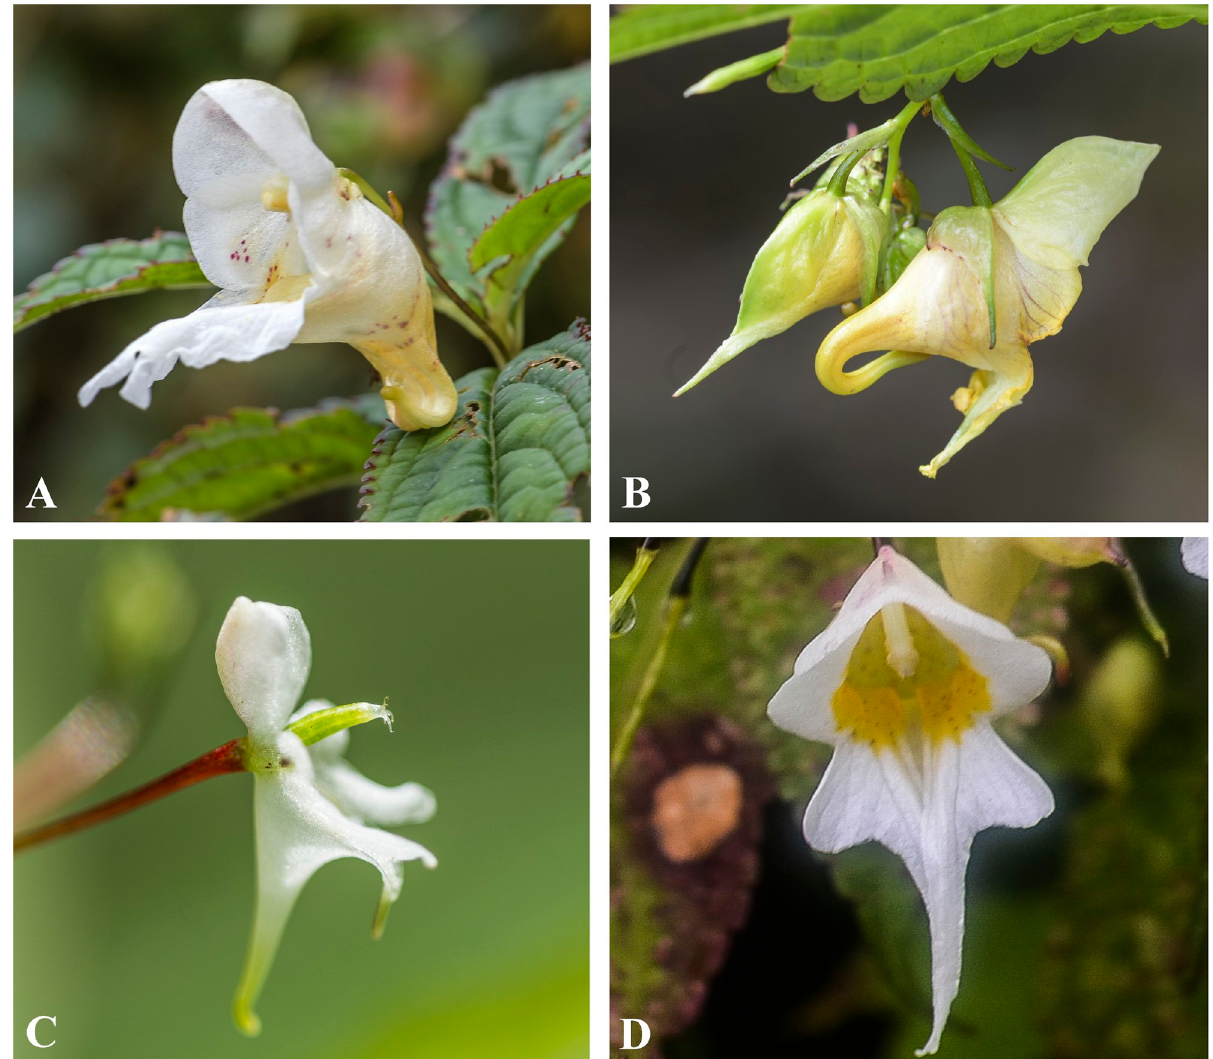
Fig 4. Flowers of Impatiens nimspurjae and its allied species: A. I. nimspurjae ; B. I . urticifolia ; C. I . radiata ; D. I . harae . Photographs by Bhakta Bahadur Raskoti.